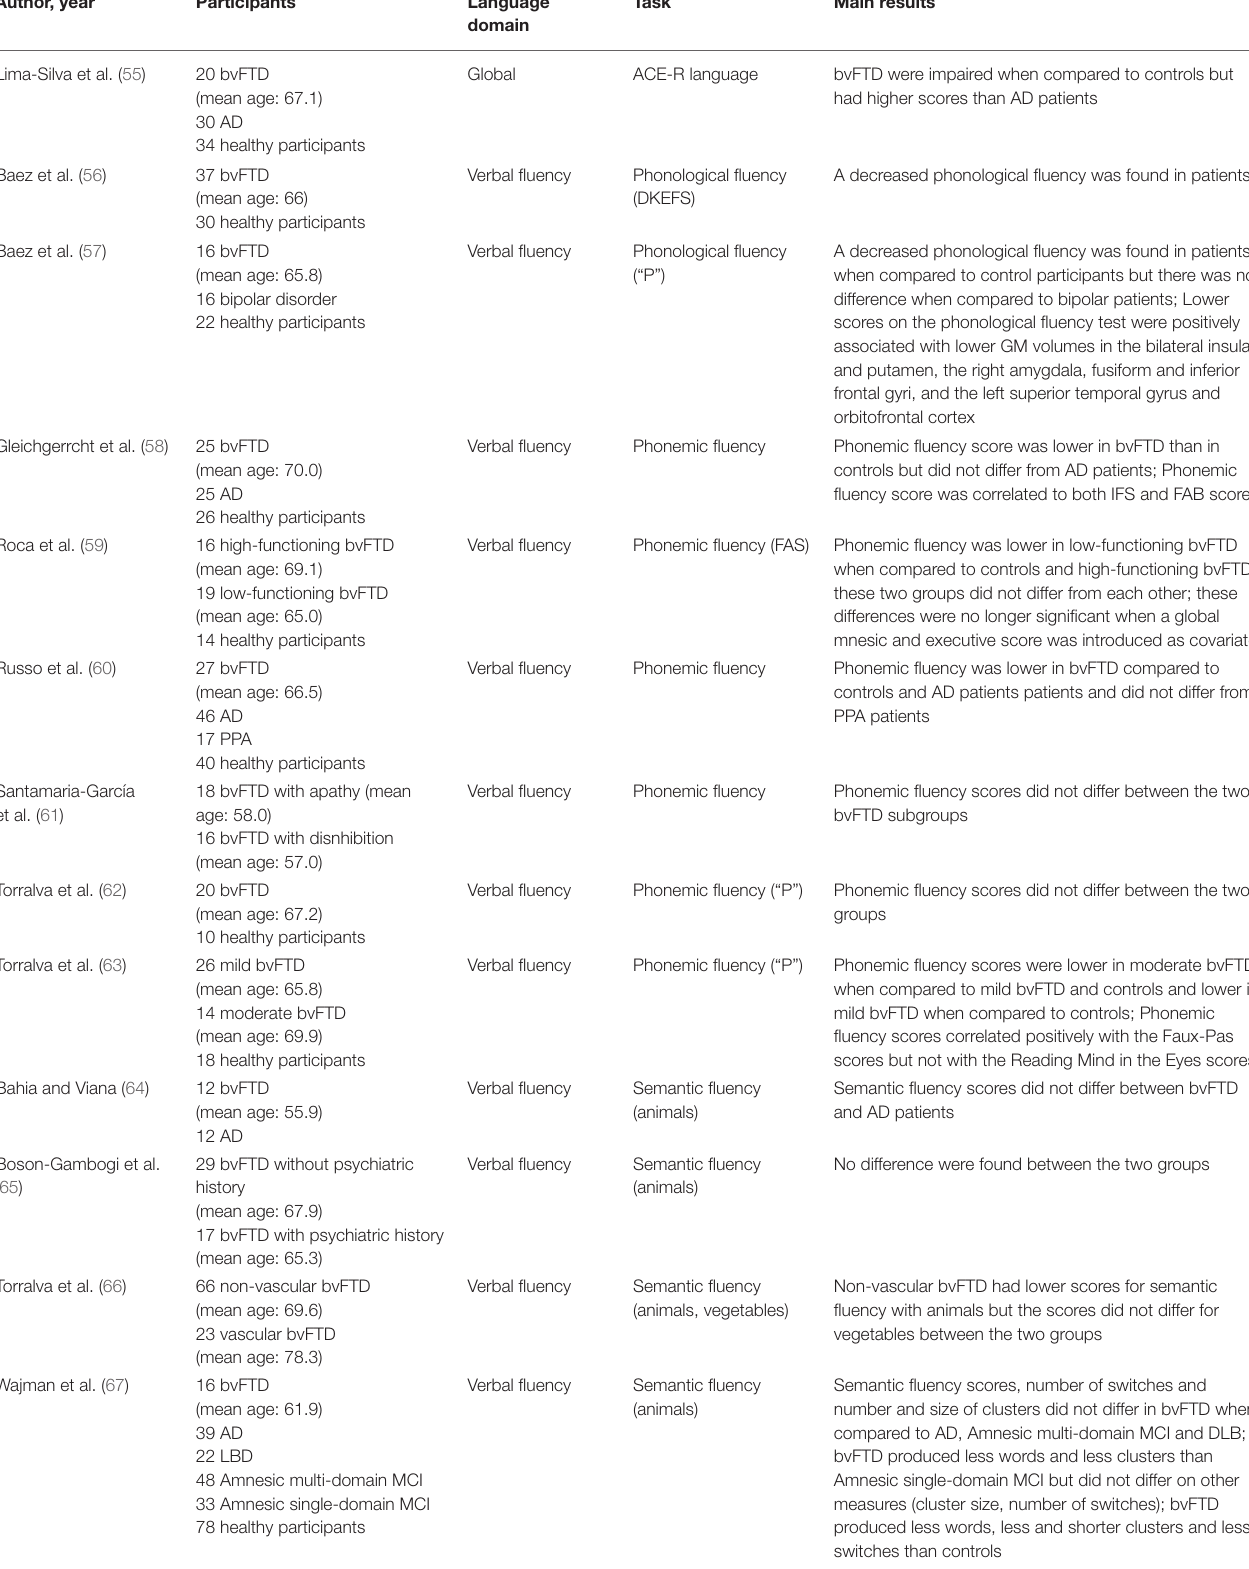
TABLE 1 | Summary of studies reporting language measures in Latin American bvFTD